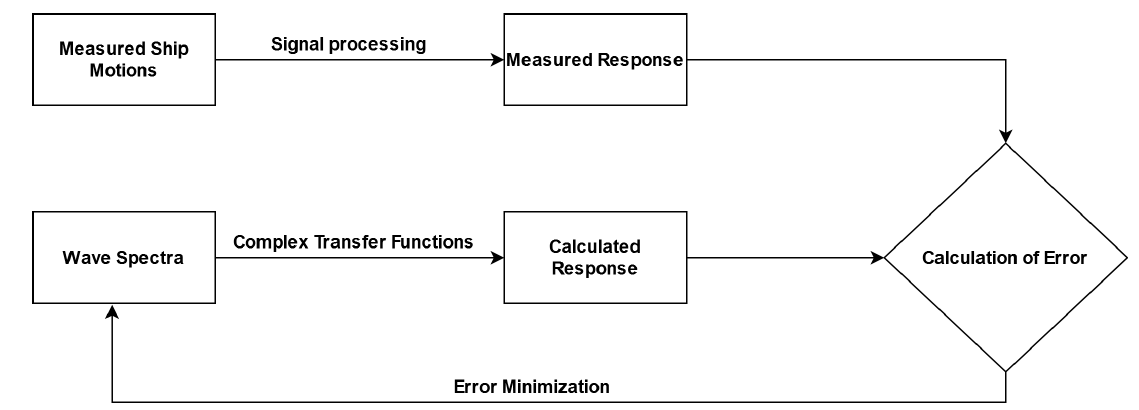
Figure 4. Block diagram of the Directional wave spectra (DWS) estimation method by using measured ship motions.